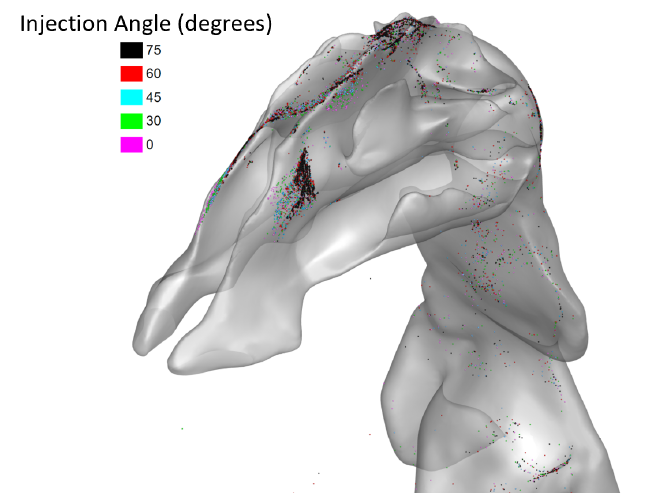
Figure 14. Particle deposition positions with varying injection angles for 100,000 A current.